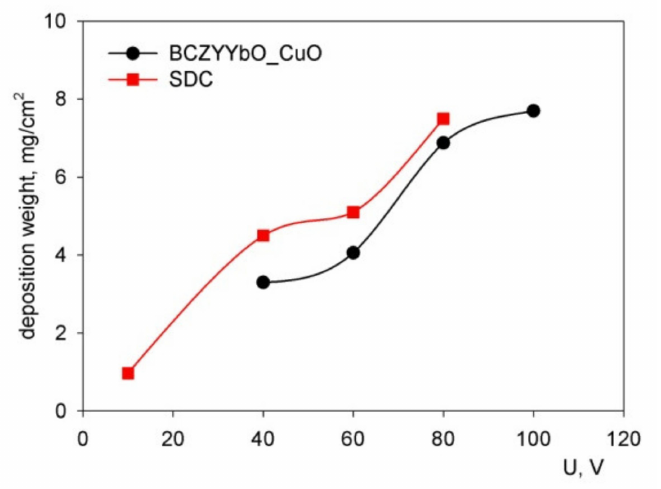
Figure 7. Dependence of the deposit weight of the BCZYYbO-CuO and SDC coatings on the deposi- tion voltage at a constant EPD time (1